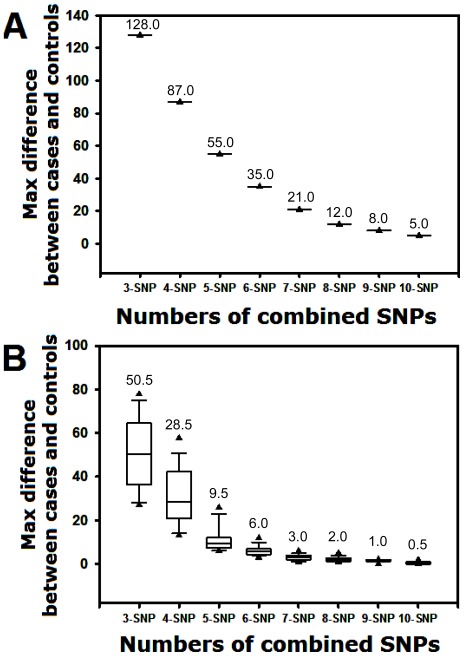
Boxplots displaying the extremes, the upper and lower quartiles, and the median of the maximum difference between cases and controls for (A) the IPSO algorithm and (B) the PSO algorithm on three to ten combined SNPs over 20 runs.The boundary of the box closest to zero indicates the 25th percentile, a line within the box marks the median, and the boundary of the box farthest from zero indicates the 75th percentile. Error bars above and below the boxes indicate the 90th and 10th percentiles, respectively. The triangle symbols indicate the 95th and 5th percentiles.